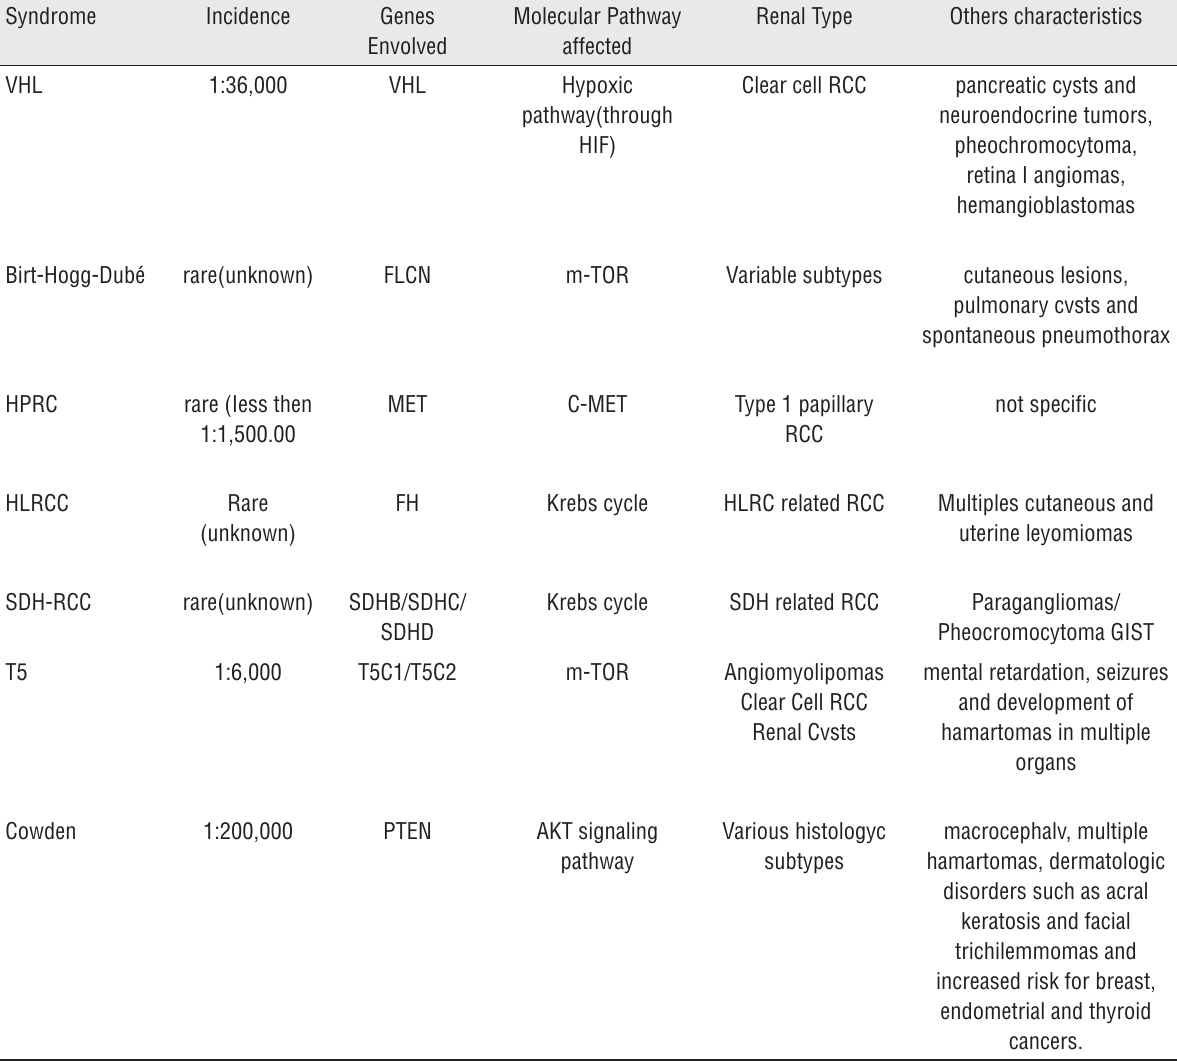
Table 2 - Familial syndromes related to development of renal cell